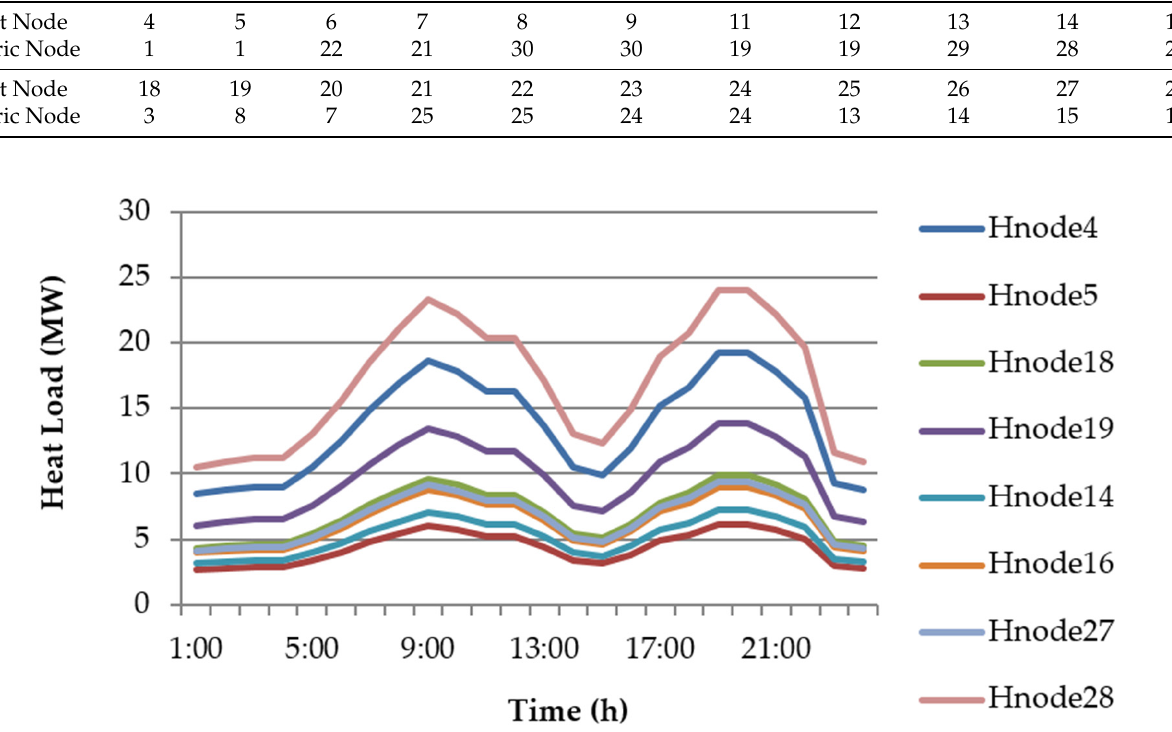
Table A5. Coupling of electric and heat nodes.